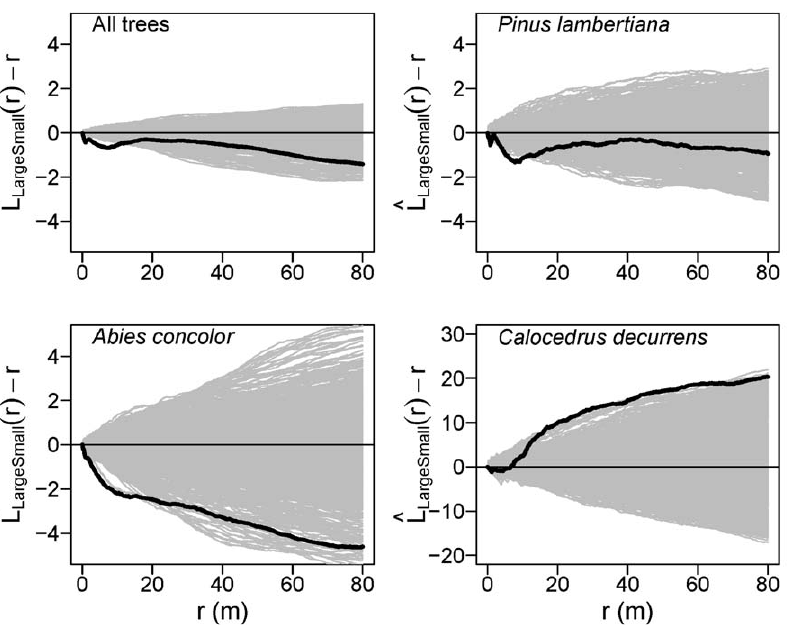
Figure 5. Spatial interactions between large-diameter and small-diameter trees. Solid black lines show the ^ LL 1,2 ( r ) statistic for the actual pattern, where r is the intertree distance; thin gray lines show ^ LL ( r ) curves for 999 patterns simulated by synchronous random torodial shifts of large and small tree subpopulations. Positive values indicate spatial attraction and negative values indicate spatial repulsion. Large-diameter trees are $ 100 cm dbh; small-diameter trees are , 100 cm dbh.